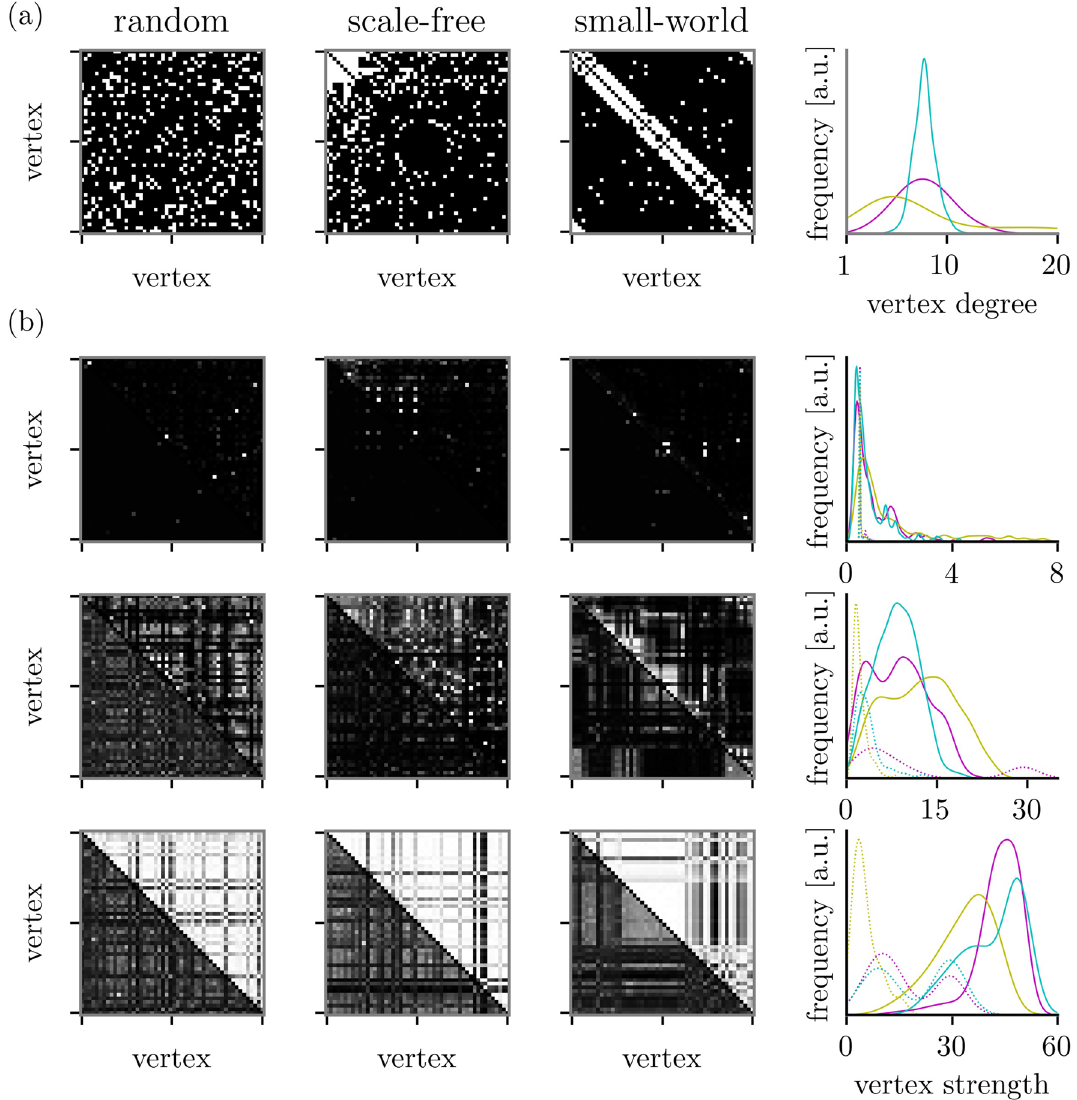
Figure 2. ( a ) Exemplary adjacency matrices of networks with paradigmatic coupling topologies. Matrix entries A = 1 are represented by white pixels and A = 0 by black pixels. ( b ) Weight matrices of corresponding ij ij functional networks with edge weights from the three regimes (top: regime I, middle: regime II, bottom: regime III). Coloring of matrix entries ranges from black ( W ij = 0 ) to white ( W ij = 1 ). The plots on the right side depict the associated degree resp. strength distributions (kernel density estimates). The degree of vertex V V A W s i = i is defined as ν i = i �= j i �= j ij and its strength as ij . Colors indicate coupling topologies (magenta: random, mustard: scale-free, and cyan: small-world). Weight matrices and strength distributions were derived (cid:31) (cid:31) with maximum lag-cross correlation (upper triangle of matrices; solid lines) and with mutual information (lower triangle of matrices; dashed